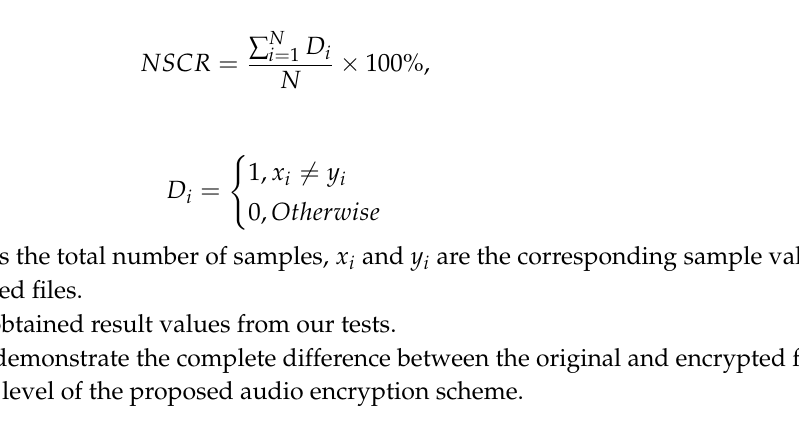
Table 5. Number of sample change